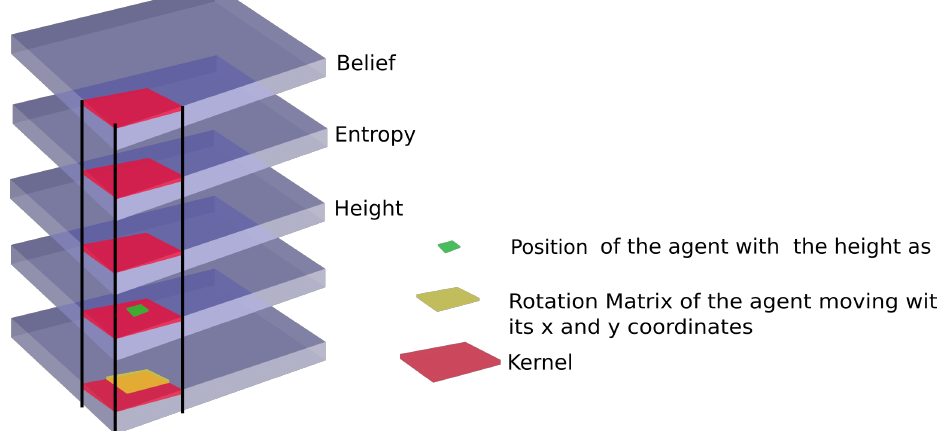
Figure 6. Representation of the state: The belief, height, entropy, position of the agent and attitude of the agent are each a 2D matrix. The picture illustrates how the kernel of the convolutional network connects the spatial information of the state already in the first